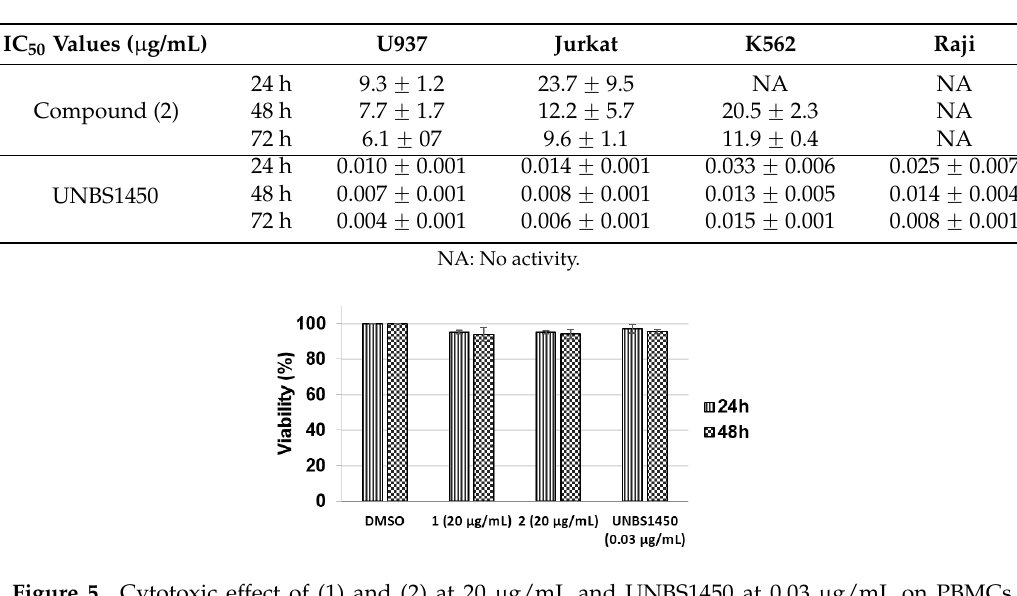
Table 1. IC 50 values of (2) and UNBS1450 (positive control) on U937 cells at 24, 48, and 72 h.